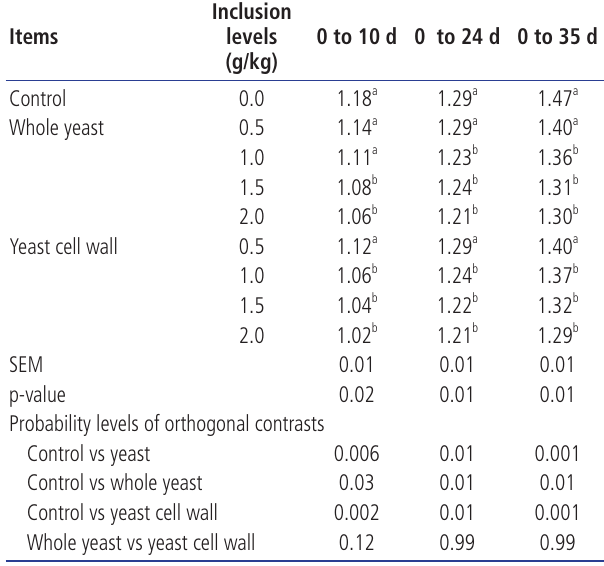
Table 4. Effects of dietary treatments on feed conversion ratio (FCR, g/g) of chicks at different ages Items